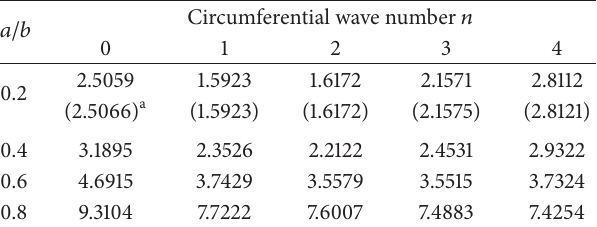
Table 6: Frequency parameters, Ω = 𝜔𝑏(𝜌(1 − V 2 )/𝐸) 1/2 , for C-SS1 annular plates with various cutout ratios.